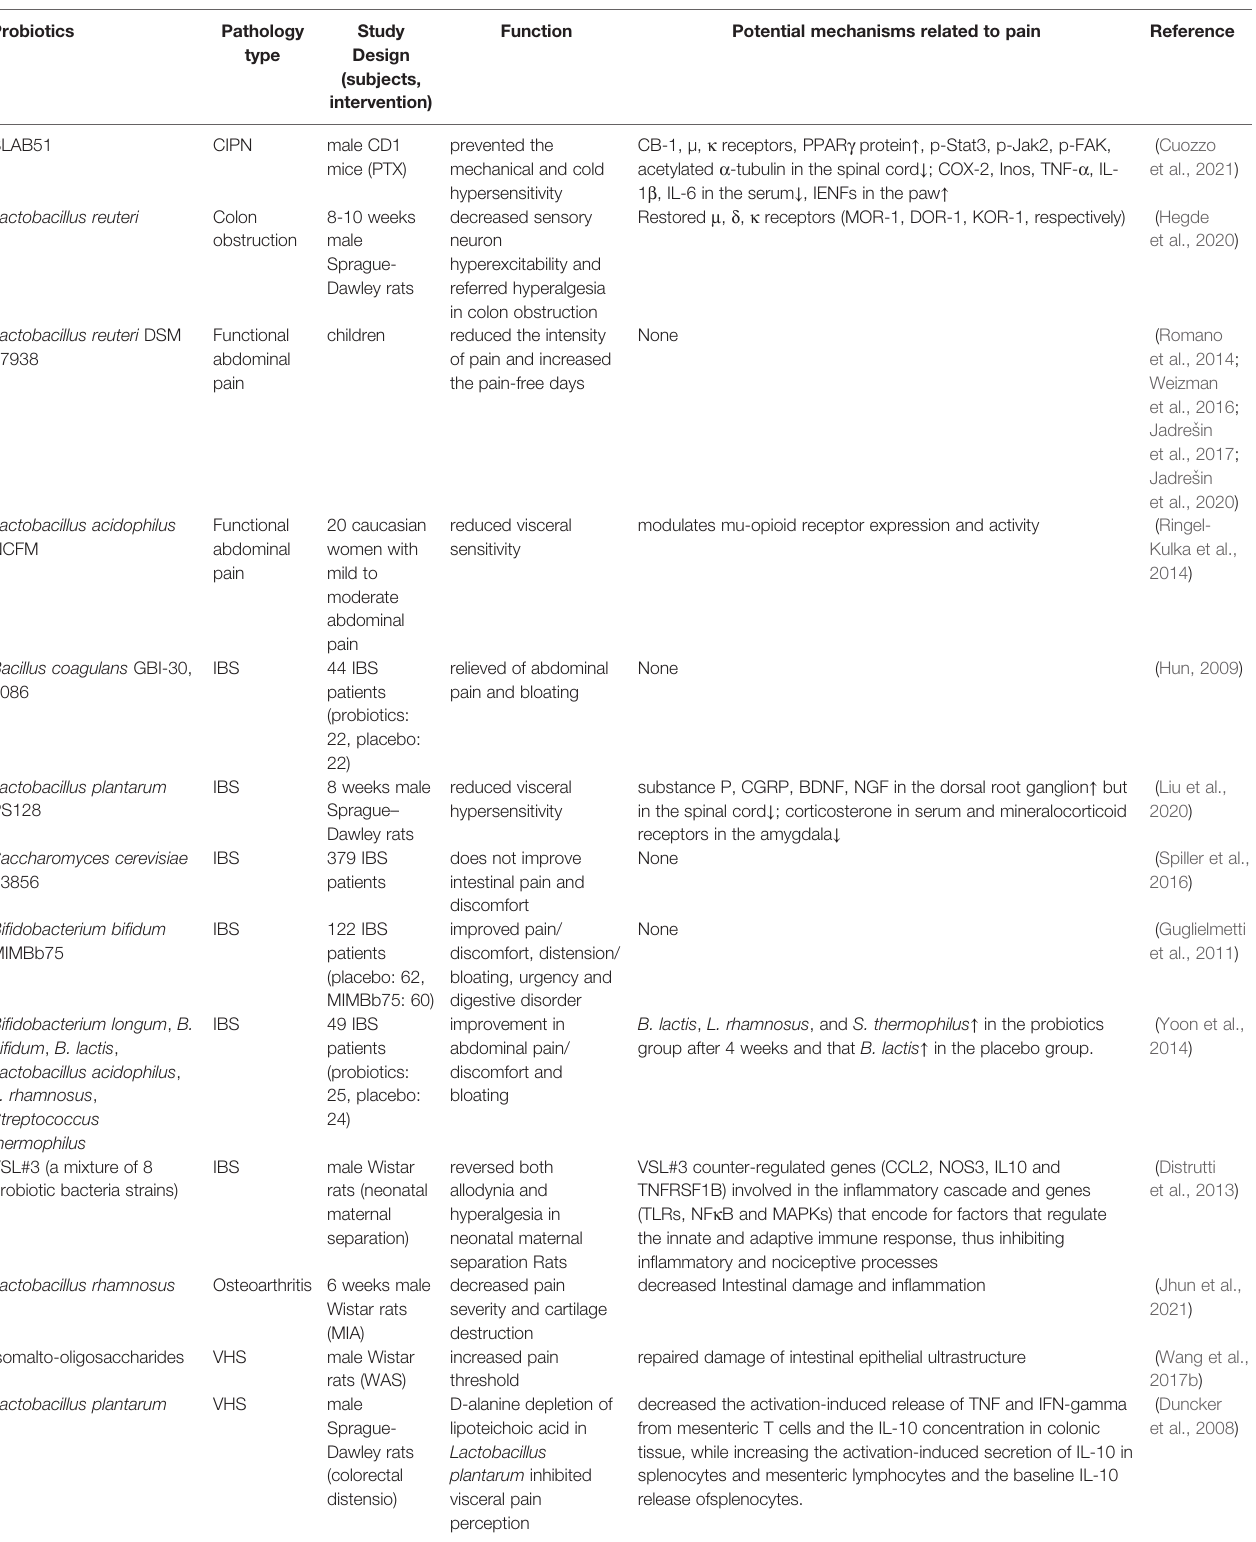
TABLE 2 | Summary of probiotics associated with the underlying mechanisms of pain.